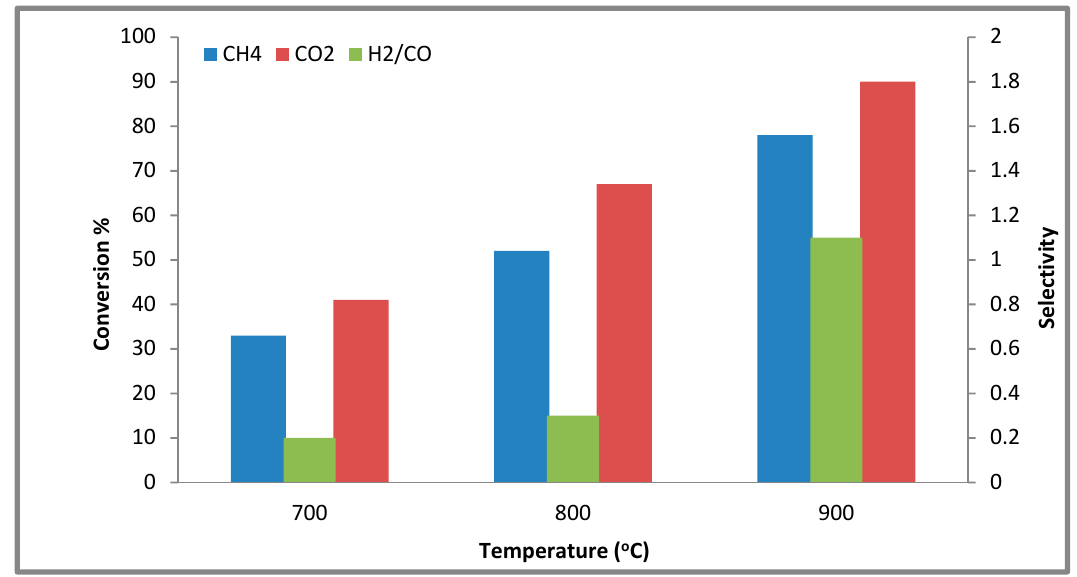
Figure 10. The effect of various temperatures on the activity of Ni,Pd,Pt/Mg 0.85 Ce 4+0.15 O catalyst. 700 Figure 10. The e ff ect of various temperatures on the activity of Ni,Pd,Pt / Mg 0.85 Ce 4 + 0.15 O catalyst. °C; 800 °C; 900 °C at a CH 4 :CO 2 ratio of 1:1, with GHSV = 15000 mL h − 1 g − 1 cat. 700 ◦ C; 800 ◦ C; 900 ◦ C at a CH 4 :CO 2 ratio of 1:1, with GHSV = 15,000 mL h − 1 g − 1